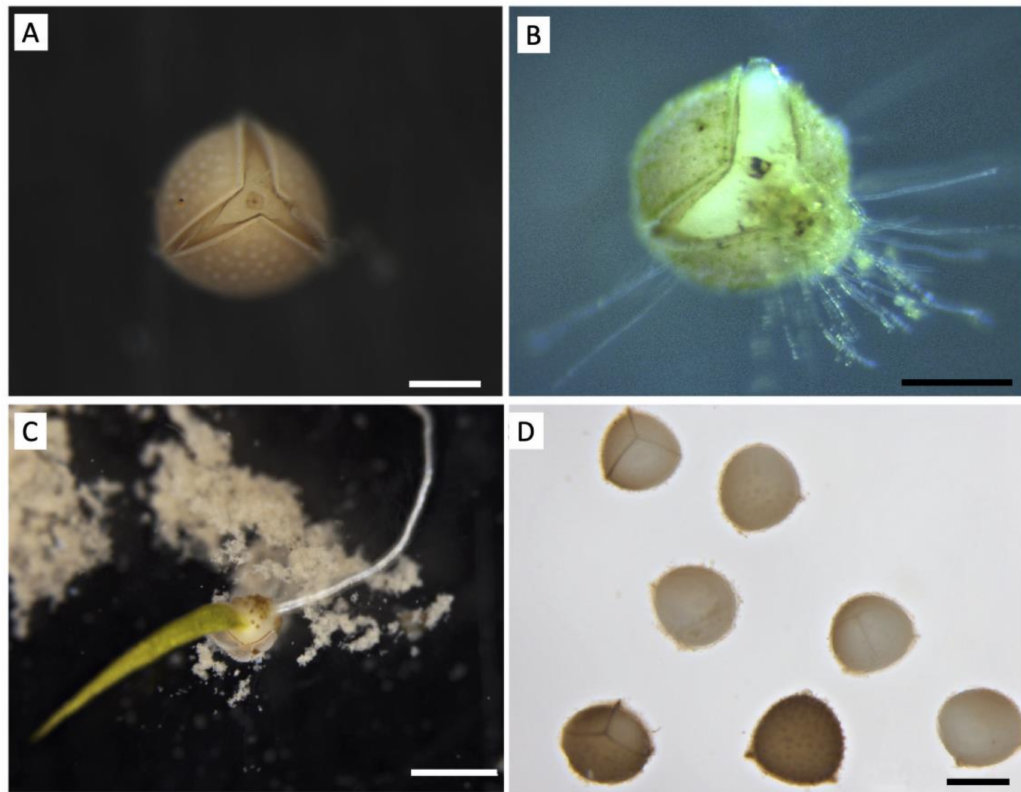
Figure 2. Megaspore germination and sporophyte formation in Isoetes cangae . ( A ) Megaspore opening with archegonia exposure; ( B ) megaspore germination with rhizoid emission; ( C ) first leaf and root emission after fertilization; ( D ) mature megaspores (dark) and immature megaspores (white). Scale bars: A , B = 200 µ m; C = 1 mm; D = 500 µ